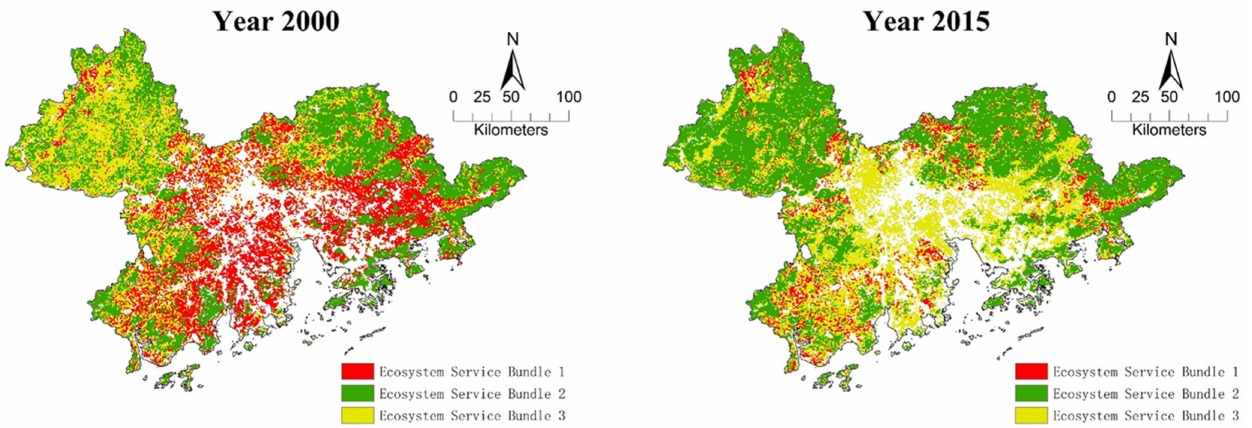
Figure 5. Spatial distribution map of ecosystem service bundles in the Greater Bay Area. Note: Ecosystem Service Bundle 1 (ESB 1)—red; Ecosystem Service Bundle 2 (ESB 2)—green; Ecosystem Service Bundle 3 (ESB